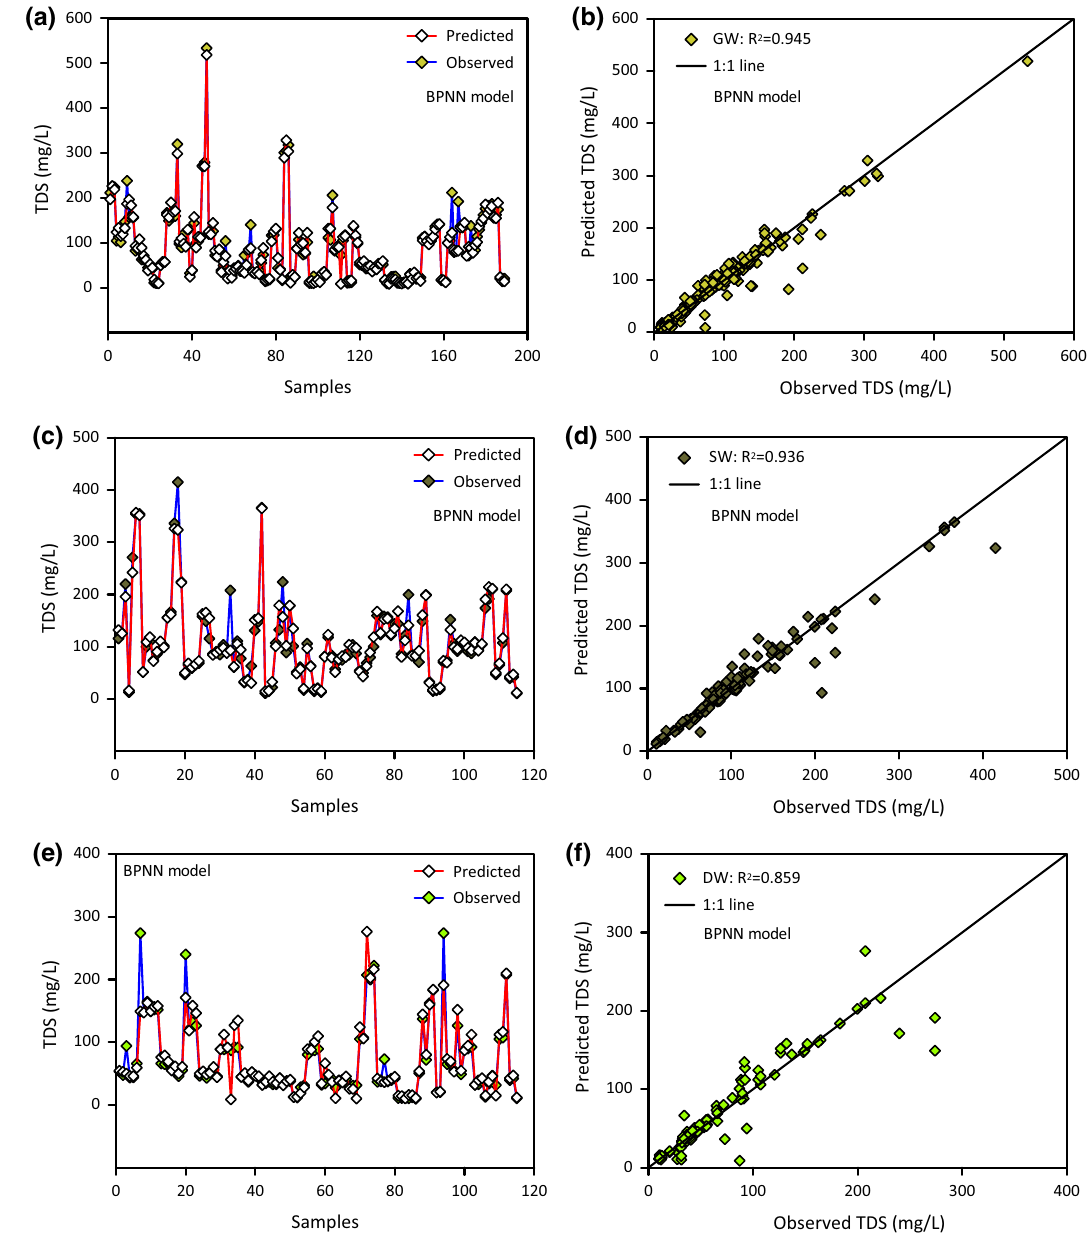
Fig. 6 Performance of BPNN model: a predicted TDS for each sam- pling points in GW; b predicted vs observed TDS in GW; c predicted TDS for each sampling points in SW; d predicted vs observed TDS in